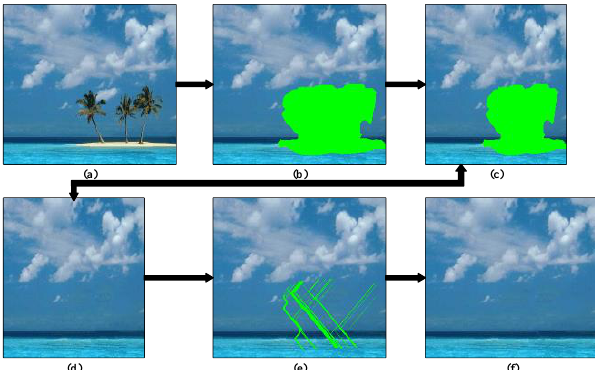
Figure 3. Inpainting-based seam carving technique, (a) Original image. (b) Masked image (image with the occluded region). (c) Shrinking occluded region by removing 30 seams. (d) Inpainted image of the shrunk region using TEBI method. (e) Returning the seams to the inpainted region. (f) Inpainting of image seams using